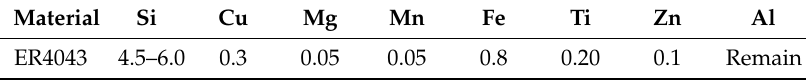
Table 3. Chemical composition of welding wire ER4043 (wt %).